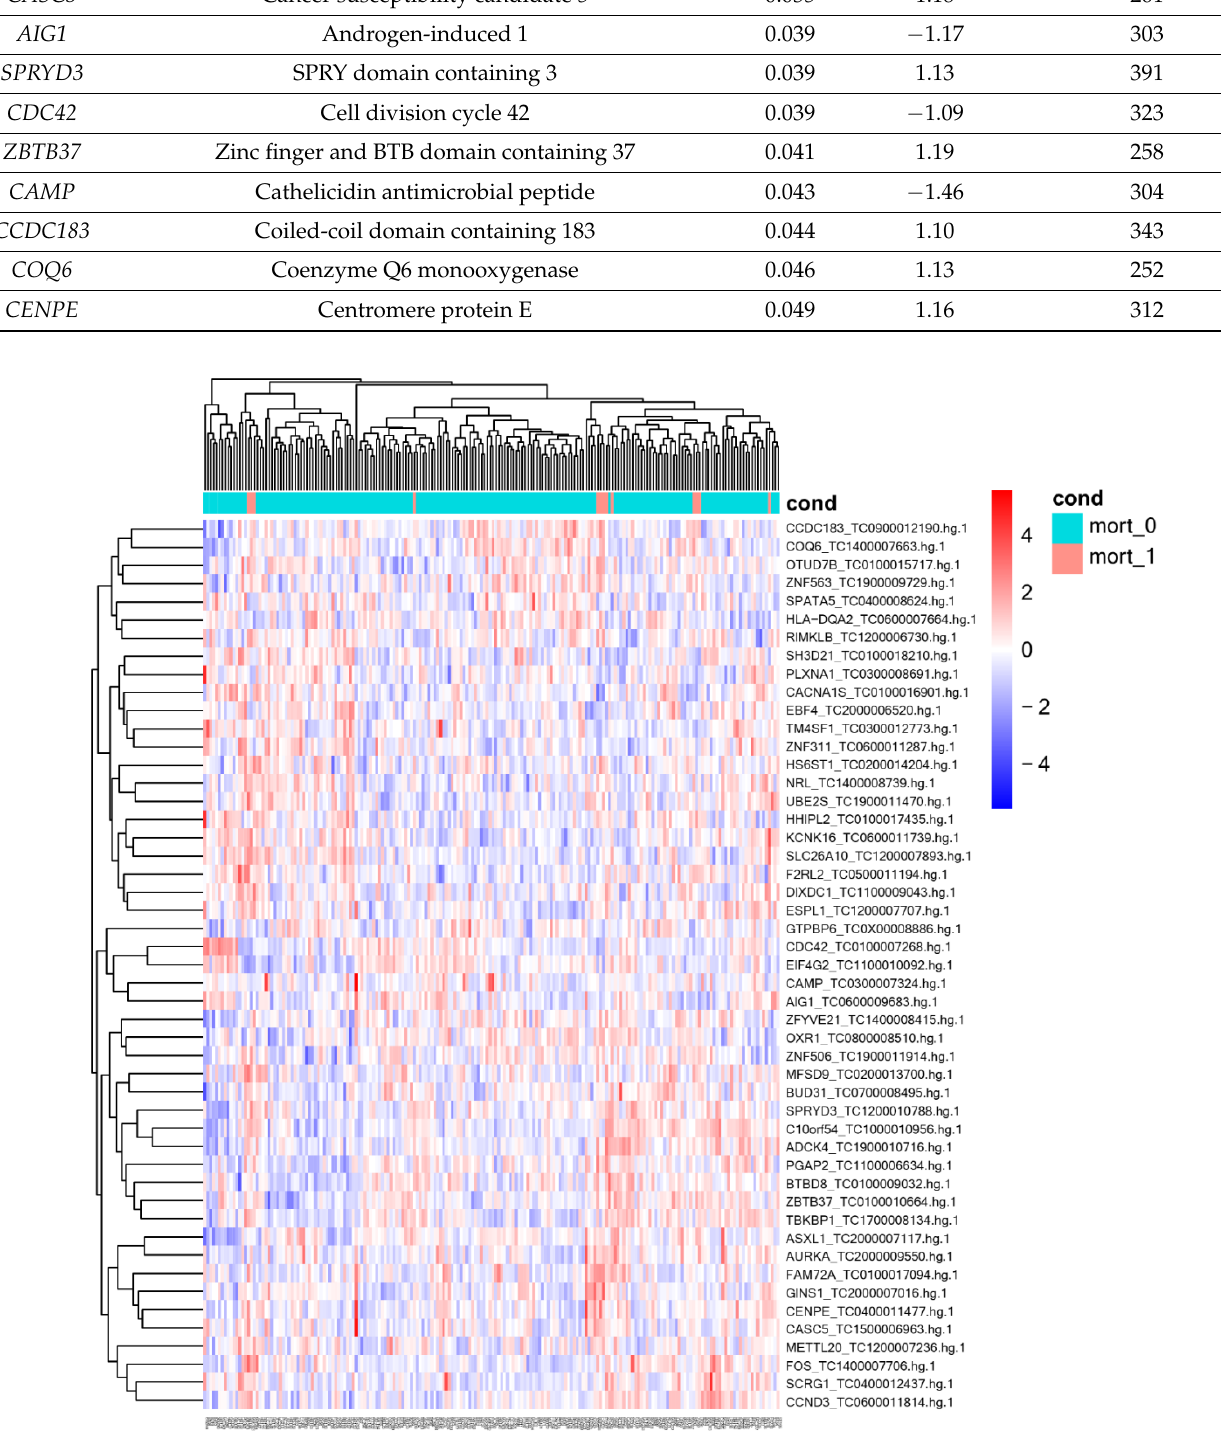
Figure 1. Heatmap of differentially expressed genes between community-acquired pneumonia patients who survived and died. mort_0, patients who survived; mort_1, patients who